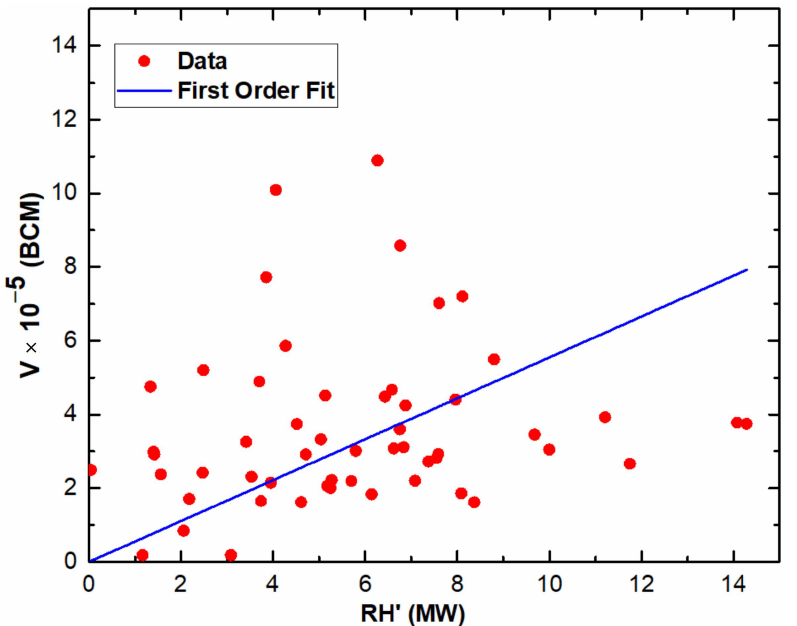
Figure 9. The established intercepting zero “first-order” polynomial regression model, using all April and May 2020 days, by means of the proposed unmixing approach and the provided “daily” in situ flared gas